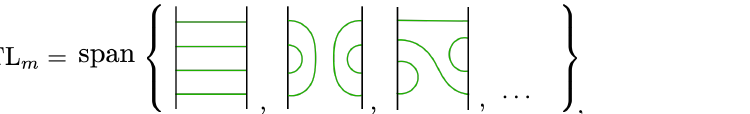
Figure 10 . A non-crossing permutation is represented in double line notation, where there is an incoming and outgoing line at each vertex. The mapping from h ∈ NC thought of as slicing the circle in half and straightening the two boundary arcs into lines while preserving the